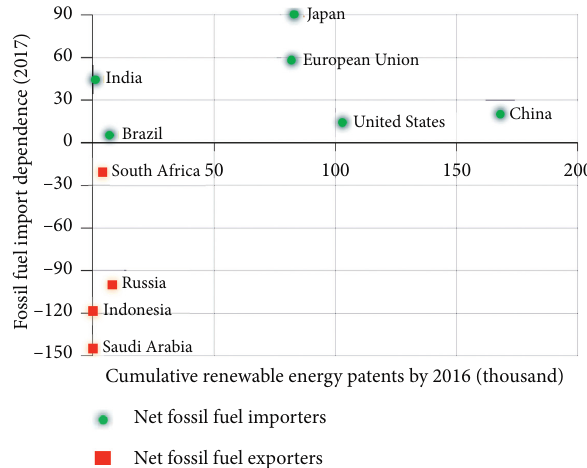
Figure 6: Energy transition and its impact on top economies